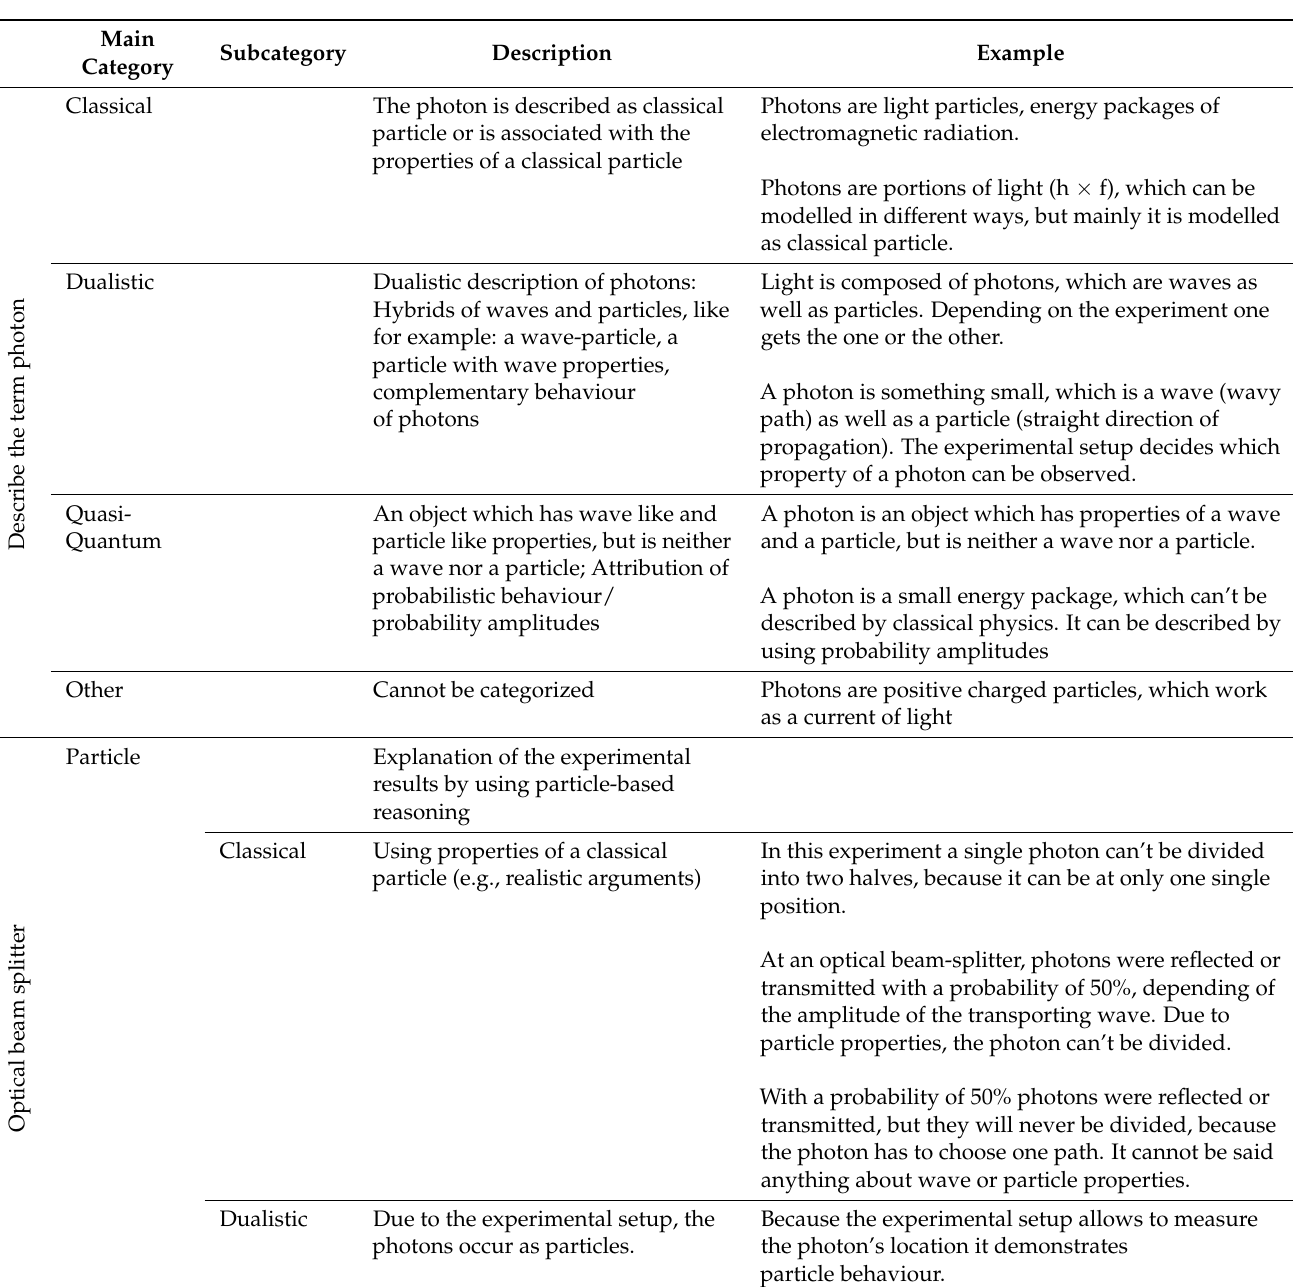
Table 4. Categorial system used to analyse the interview data; the first column refers to the three basic tasks, the second and third columns show main categories and subcategories derived from paraphrasing the individual responses, paraphrases are described in the fourth column, the last column gives an